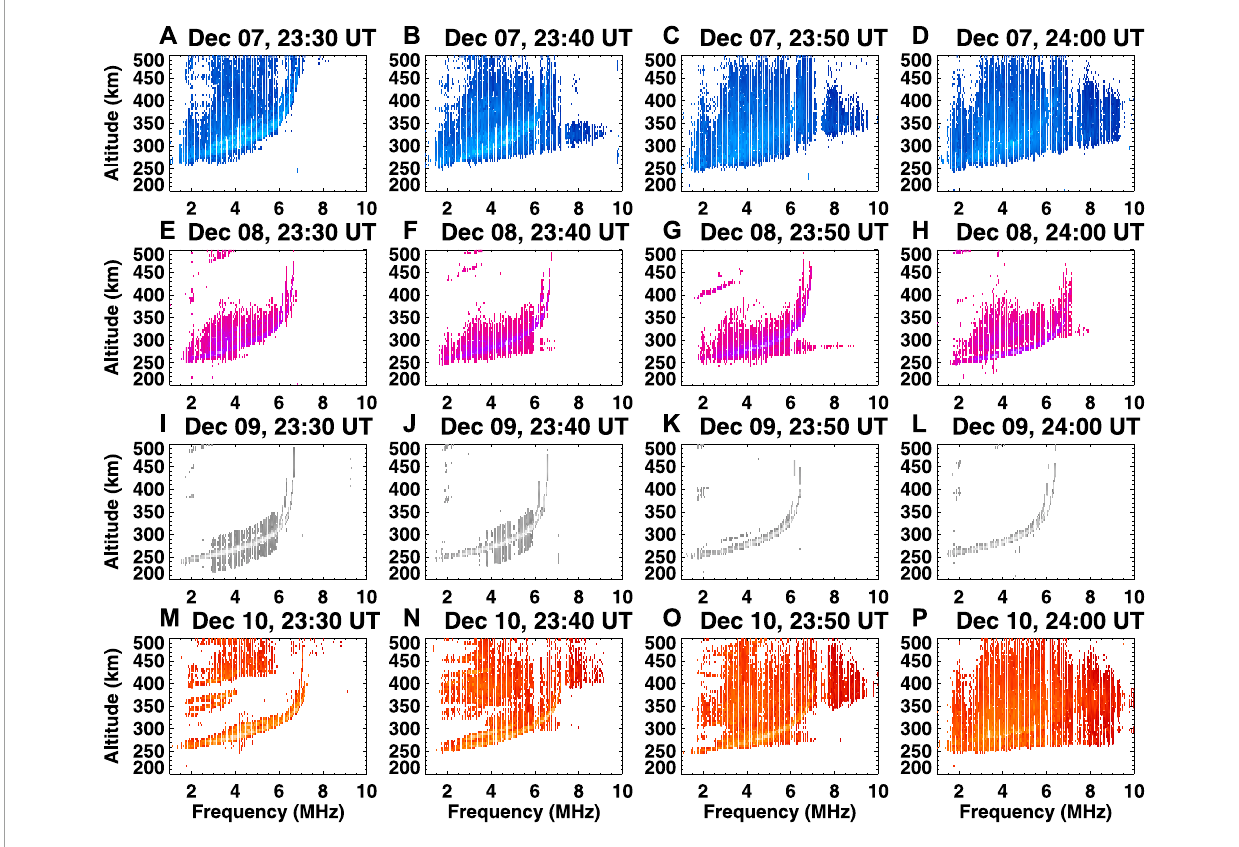
FIGURE 2 (A–P) Sao Luis ionograms during 23:30–24:00 UT on December 07 (blue), 08 (purple), 09 (silver), and 10 (red), 2019,